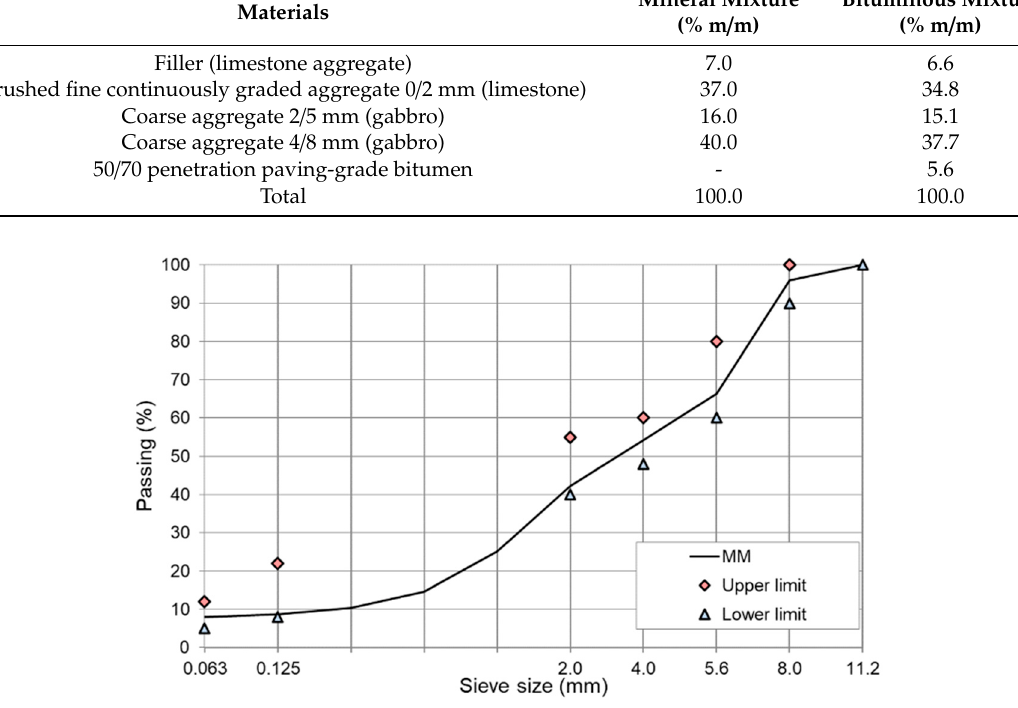
Figure 2. Grading curve of AC 8 mineral mixture with limiting points as in WT-2 2014 requirements [68].